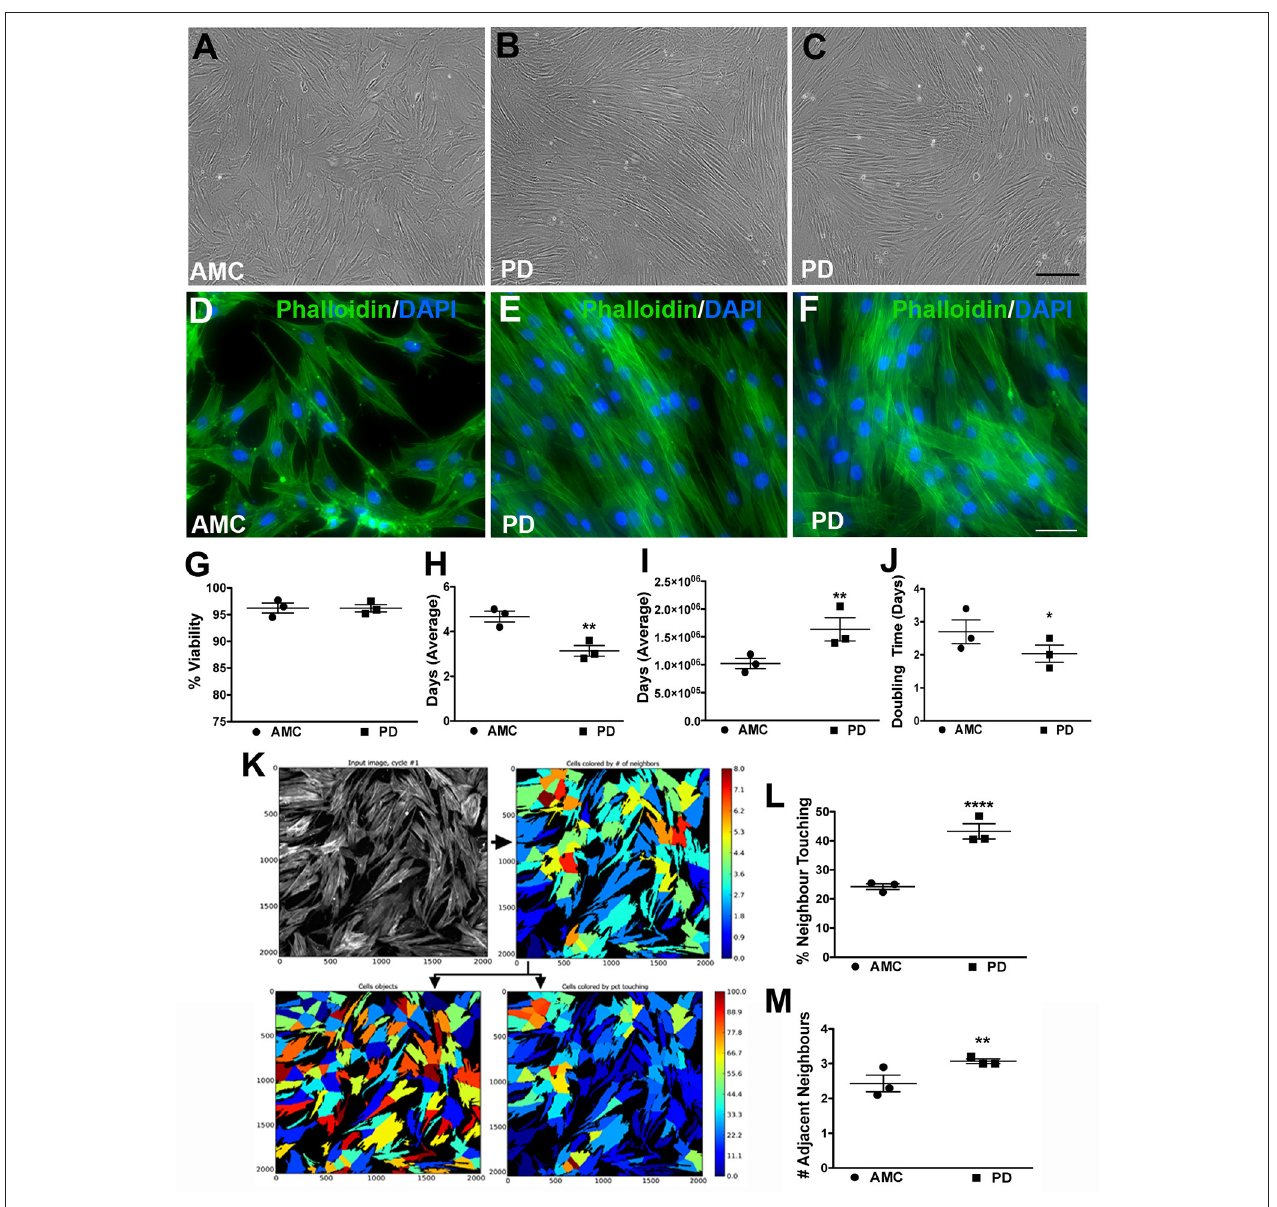
FIGURE 1 | Growth and morphology differences between AMC and PD fibroblasts. PD and AMC fibroblasts exhibited distinct growth patterns in culture (A–F) . No differences in cell viability, assessed via a trypan blue assay, were noted between PD and AMC cultures (G) . However, the number of days needed to reach 75% confluence (H) was lower in the PD cultures. Also correlatively, a higher total cell count at the 75% confluence stage (I) and a higher population doubling level (J) was noted in the PD cultures. The density of the cultures was also quantified via CellProfiler software. (K) Shows how the software outlines each “cell object” based on fluorescence staining to finally measure cellular density. Comparative analysis of density between AMC and PD in terms “percentage of Neighbor Touching” and “number of Adjacent Neighbors” is shown in (L,M) . Scale Bars: (A–C) = 100 µ m, (D–F) = 50 µ m. * p < 0.05, ** p < 0.01, **** p < 0.0001; Mean ± SEM, Unpaired t -tests with Welch’s correction, n = 3 independent PD and AMC lines.